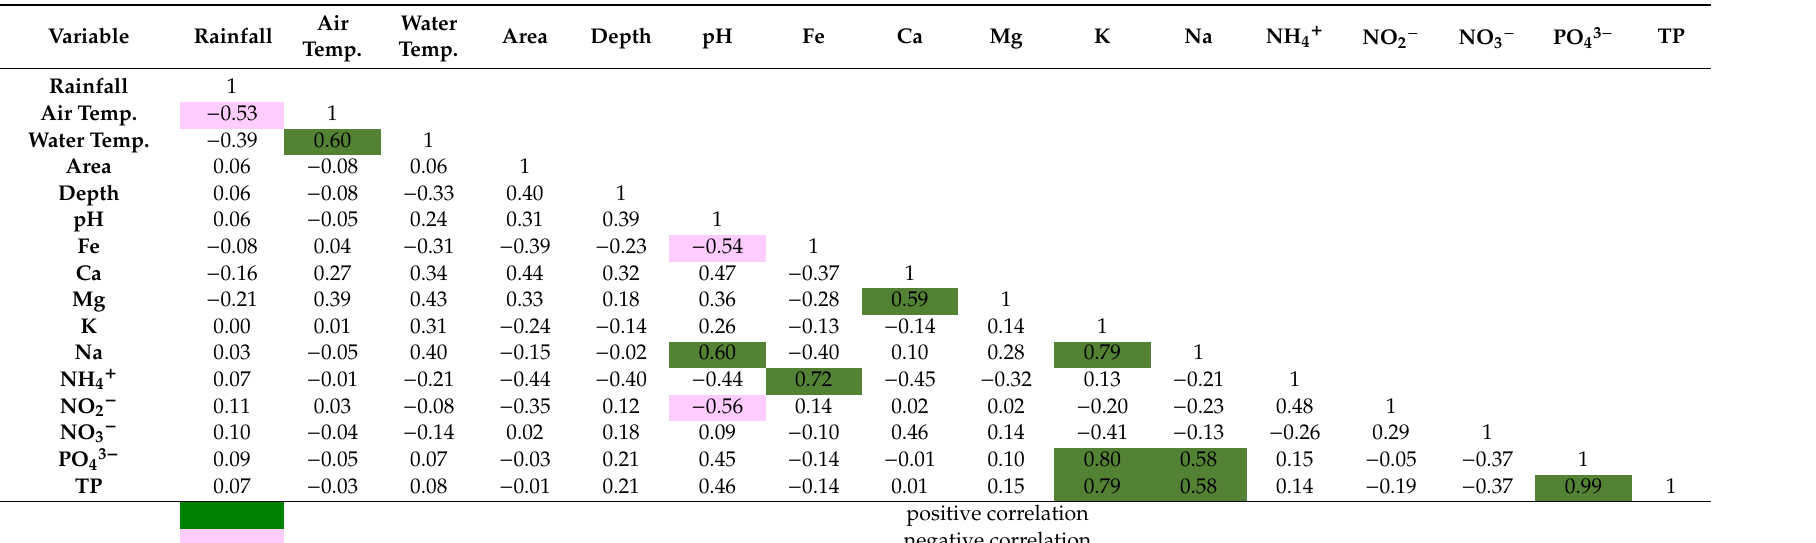
Table 9. Pearson’s correlation for the analyzed